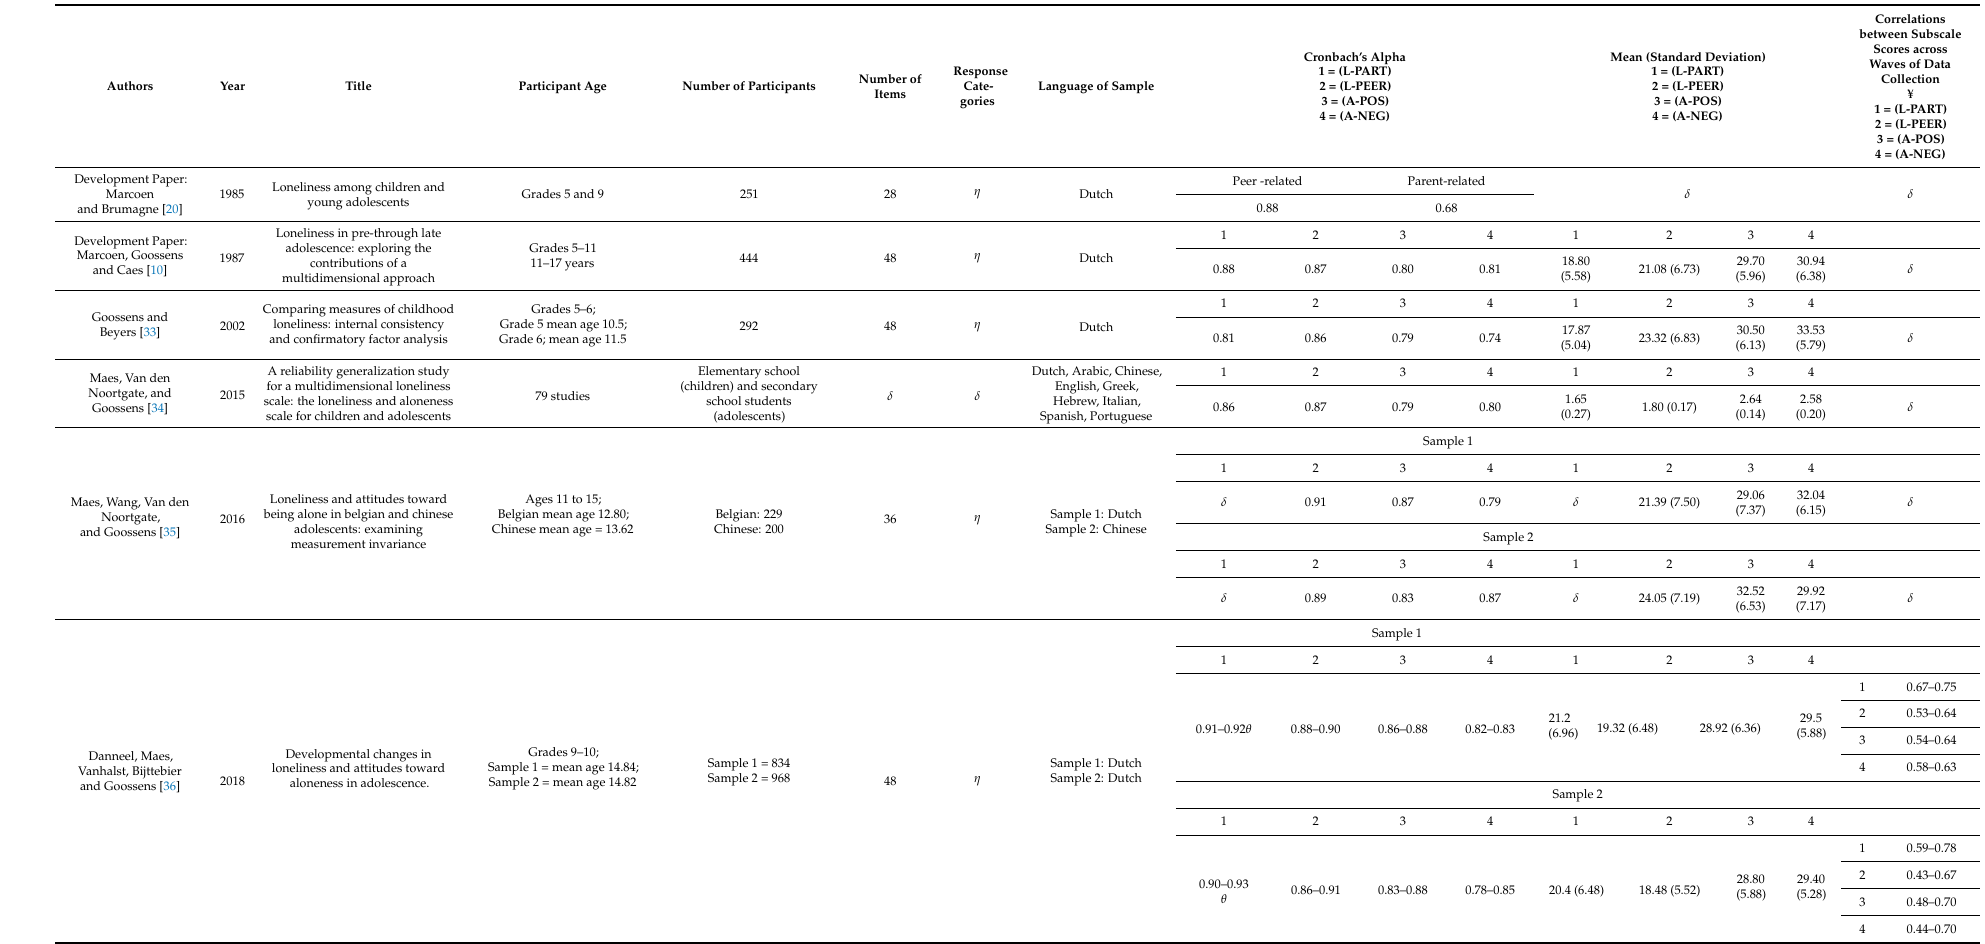
Table 2. Subsequent research papers investigating the psychometric properties of the